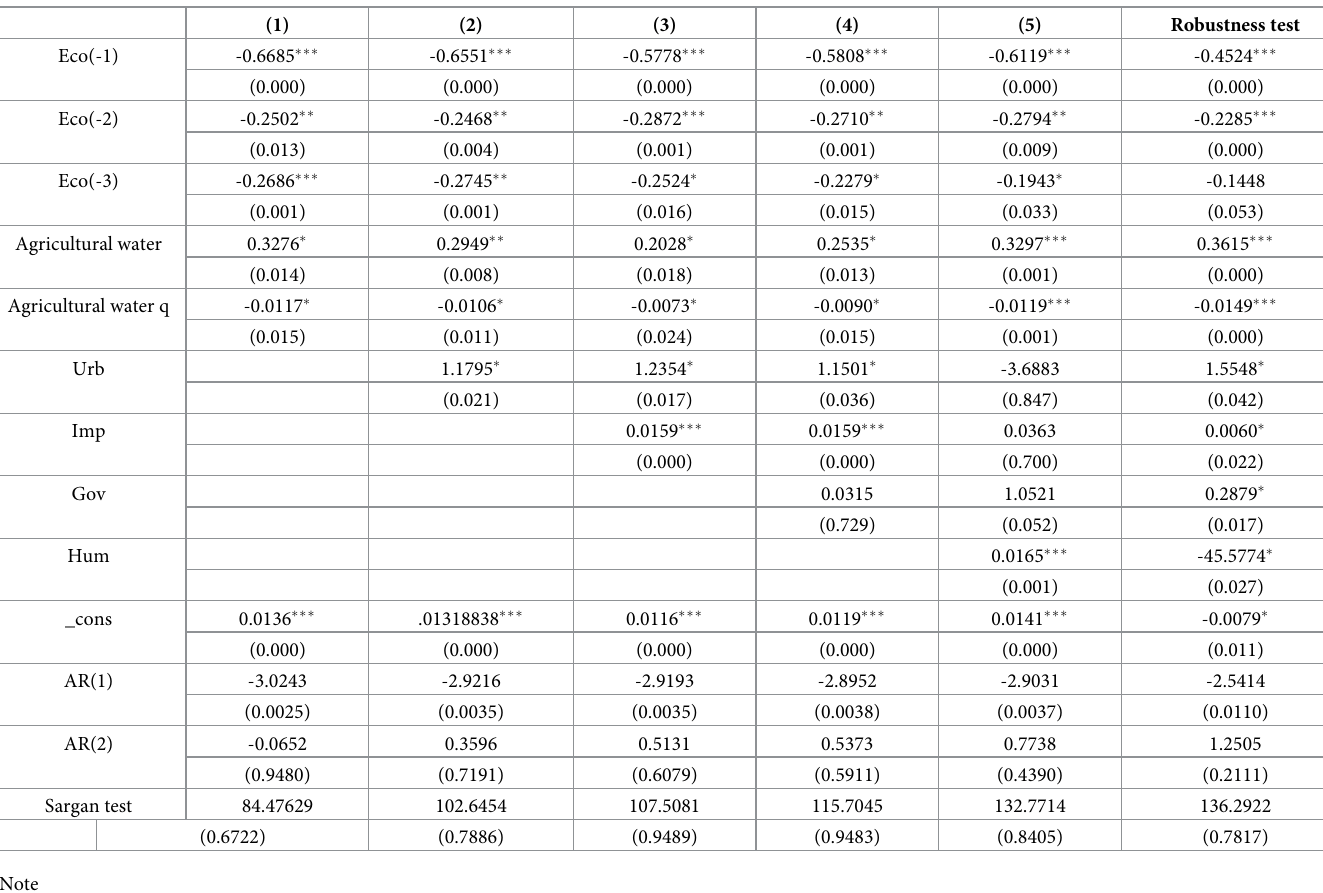
Table 2. Analysis of the impact of agricultural water salvation investment on economic